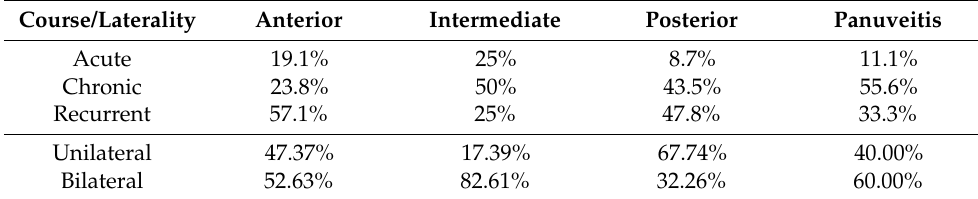
Table 4. Uveitis characteristics.